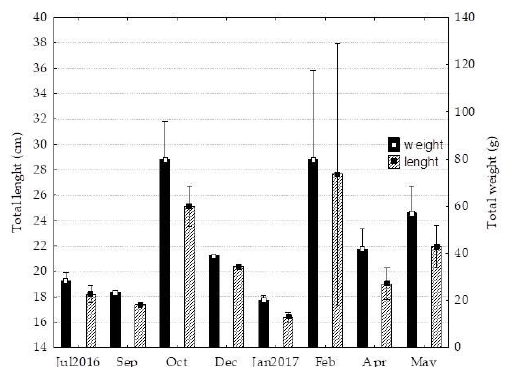
Figure 2. Mean (±std. dev.) of the Total weight and Total length of Elops saurus juvenile on the Parnaiba Delta River in the period between July (2016) to May (2017).